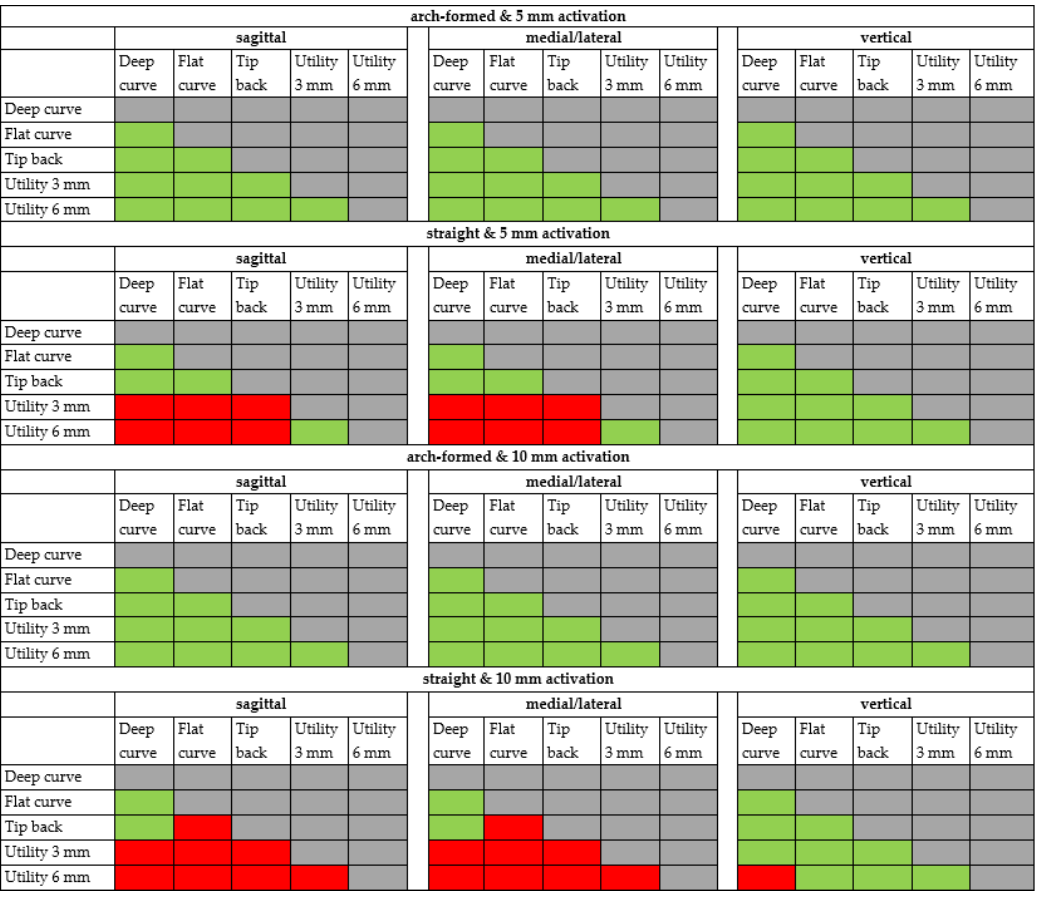
Figure 15. Comparison of the cantilever configurations by the level of significant difference. red = significant difference, green = no significant difference. Table 2. Overview of the generated forces in the sagittal, horizontal, and, vertical view. P: protrusive force, R: retractive force, M: medial force, L: lateral force, I: intrusive force, E: extrusive force, 0: change of force direction during